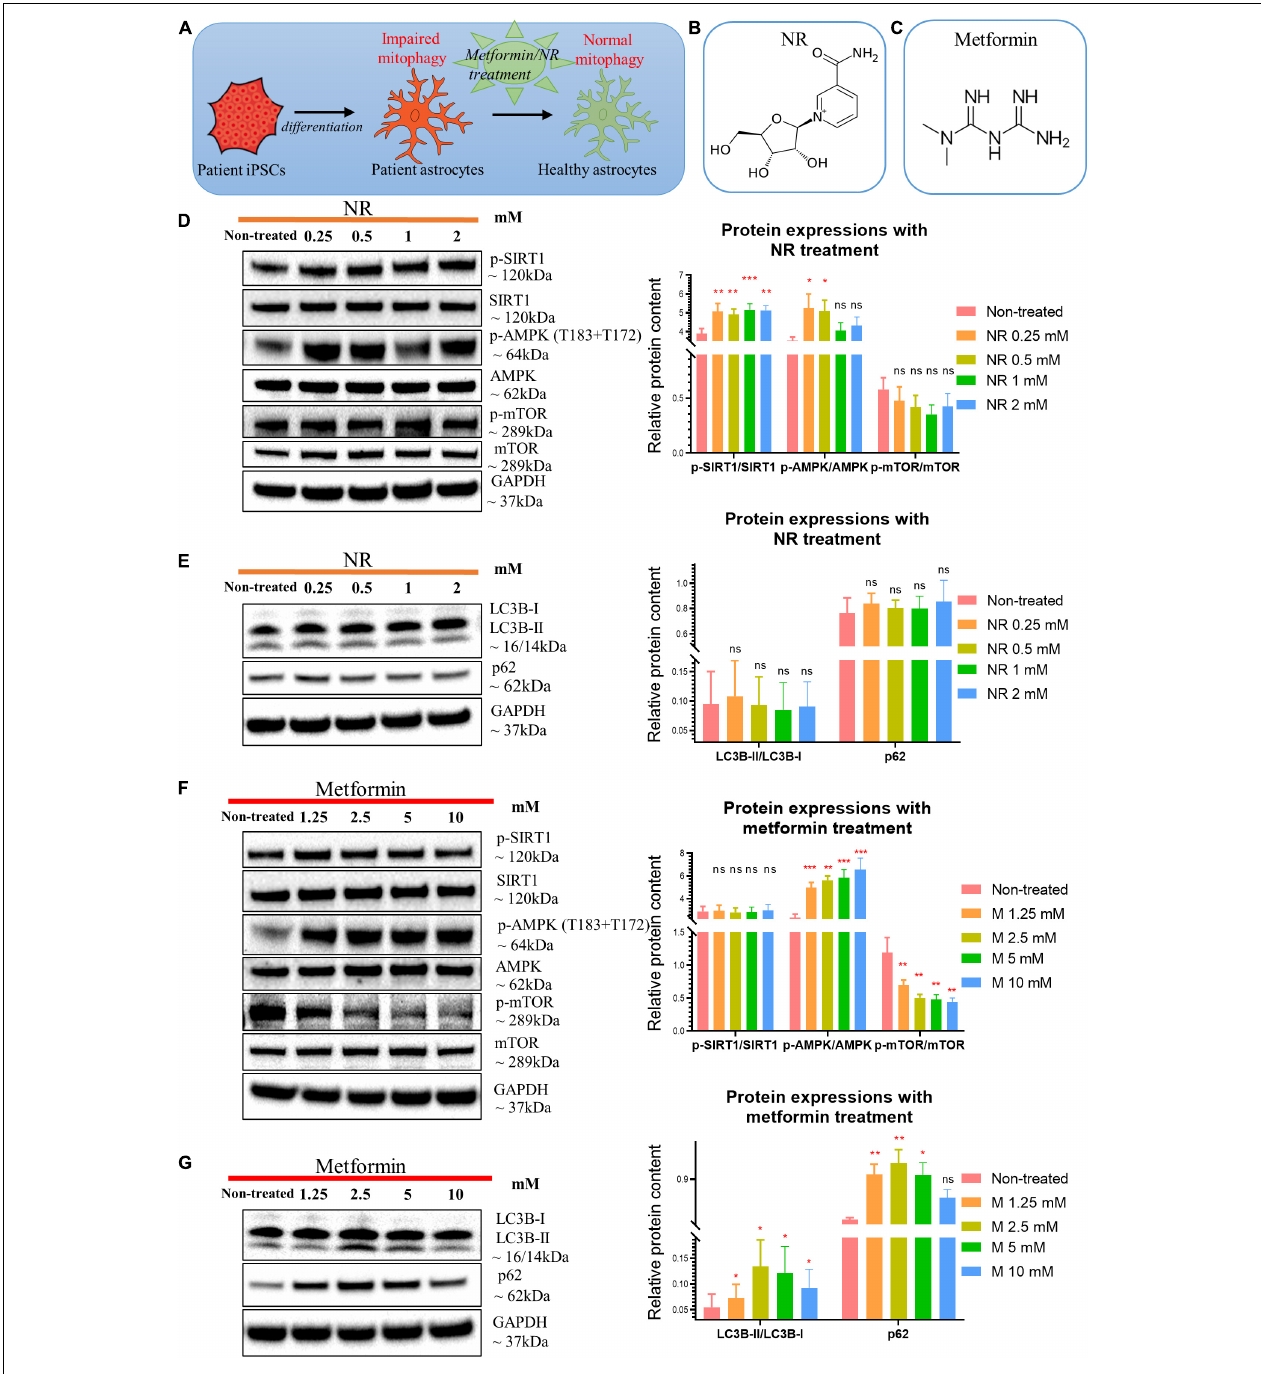
FIGURE 6 | Nicotinamide riboside and metformin treatment modulated SIRT1/AMPK/mTOR pathway in POLG-mutant astrocytes. (A) Schematic diagram of compound treatment for POLG-mutant astrocytes. (B,C) Chemical structure of NR (B) and metformin (C) . (D) Representative images and quantification of western blotting for p-SIRT1, SIRT-1, p-AMPK (T183 + T172), AMPK, p-mTOR, mTOR, and GAPDH in the POLG WS5A astrocytes treated with a serial concentration of NR alone for 72 h. (E) Representative images and quantification of the western blotting for LC3B-I, LC3B-II, p62, and GAPDH in the POLG WS5A astrocytes treated with a serial concentration of NR alone for 72 h. (F) Representative images and quantification of western blotting for p-SIRT1, SIRT1, p-AMPK (T183 + T172), AMPK, p-mTOR, mTOR, and GAPDH in the POLG WS5A astrocytes treated with a serial concentration of metformin alone for 72 h. (G) Representative images and quantification of the western blotting for LC3B-I, LC3B-II, p62, and GAPDH in the POLG WS5A astrocytes treated with a serial concentration of metformin alone for 72 h. Data information: the data in D–G represent one clone from WS5A. Mann–Whitney U test was used for the data presented in D–G . Significance is calculated by comparison to non-treated cells and is denoted for p -values of less than 0.05. * p < 0.05; ** p < 0.01; *** p < 0.001; ns, not significant.